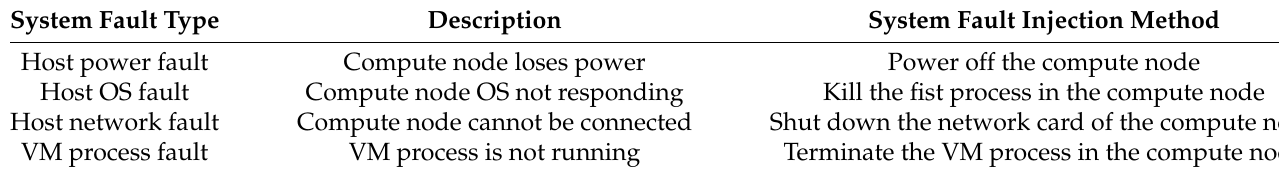
Table 10. System fault injection method.